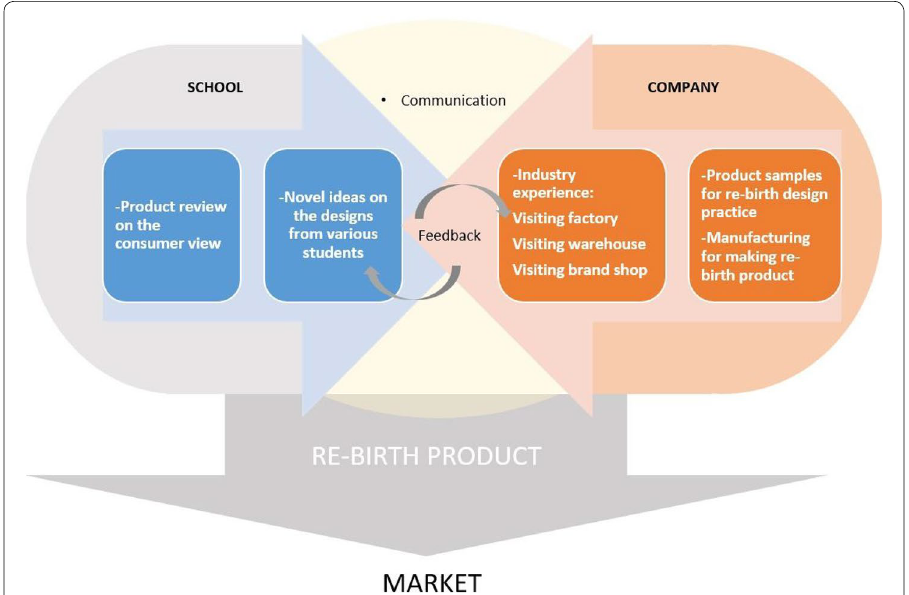
Fig. 1 Collaborative re-birth fashion handbag design